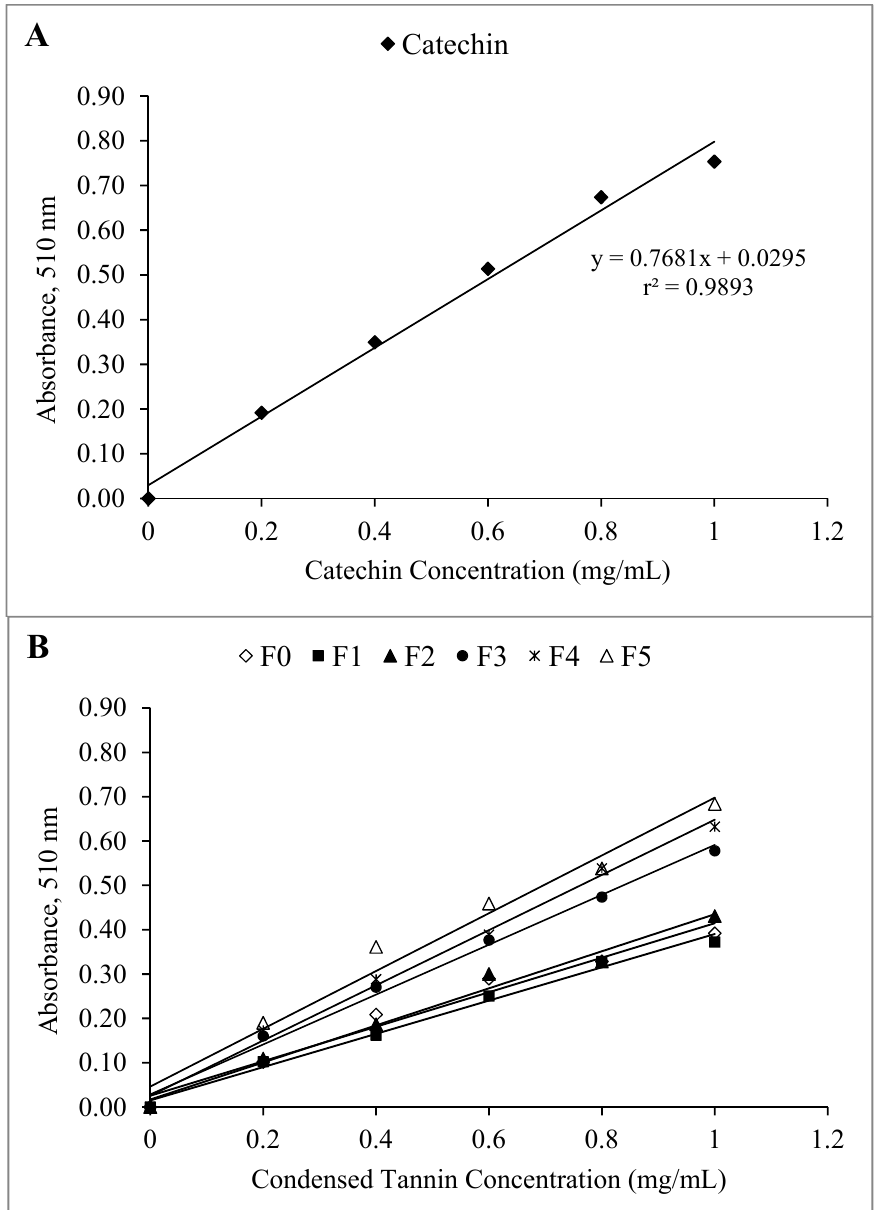
Figure 3. Standard curve ( A ) of the reaction of catechin with vanillin in glacial acetic acid and sample curves ( B ) of the reaction of CT fractions with vanillin in glacial acetic acid. The standard deviations (SD) for catechin ( A ) and samples ( B ) in the vanillin assay were below 0.02.